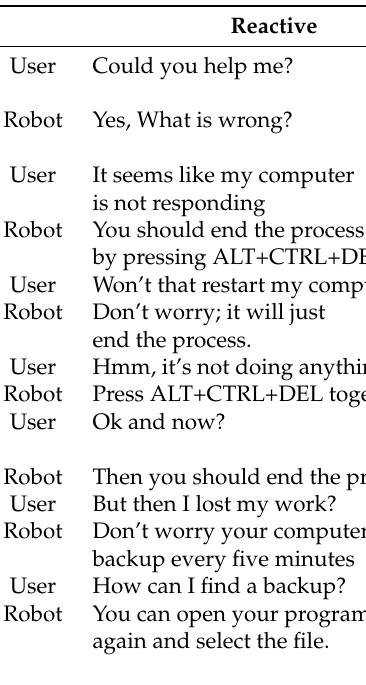
Table A1. Reactive vs. Proactive